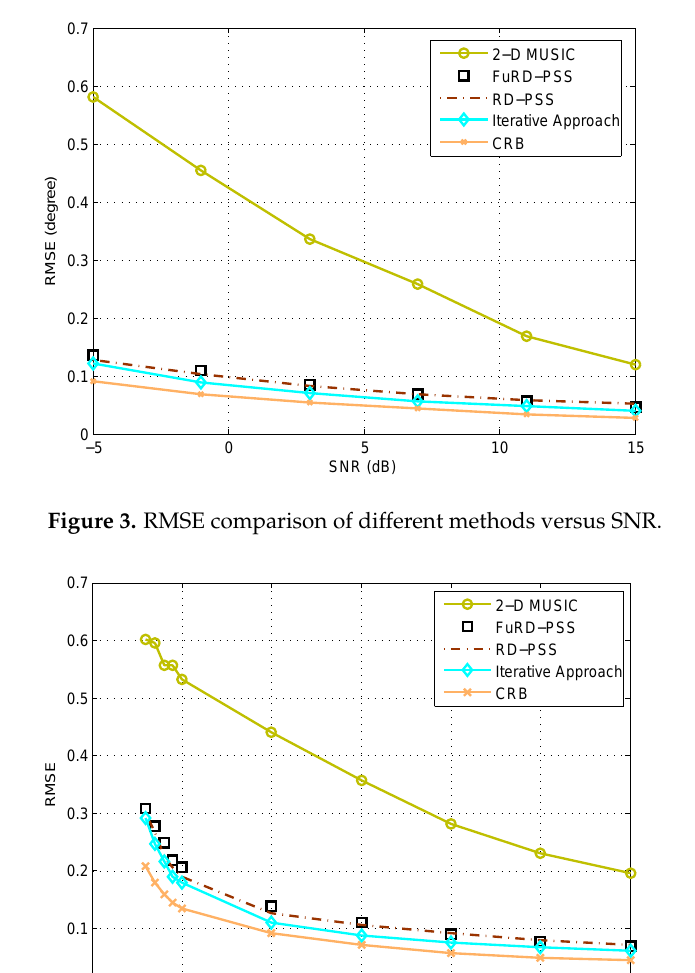
Figure 2. DOA estimation results for the proposed algorithm with K = 12 sources and M 1 = N 1 = 3, M 2 = N 2 = 7.